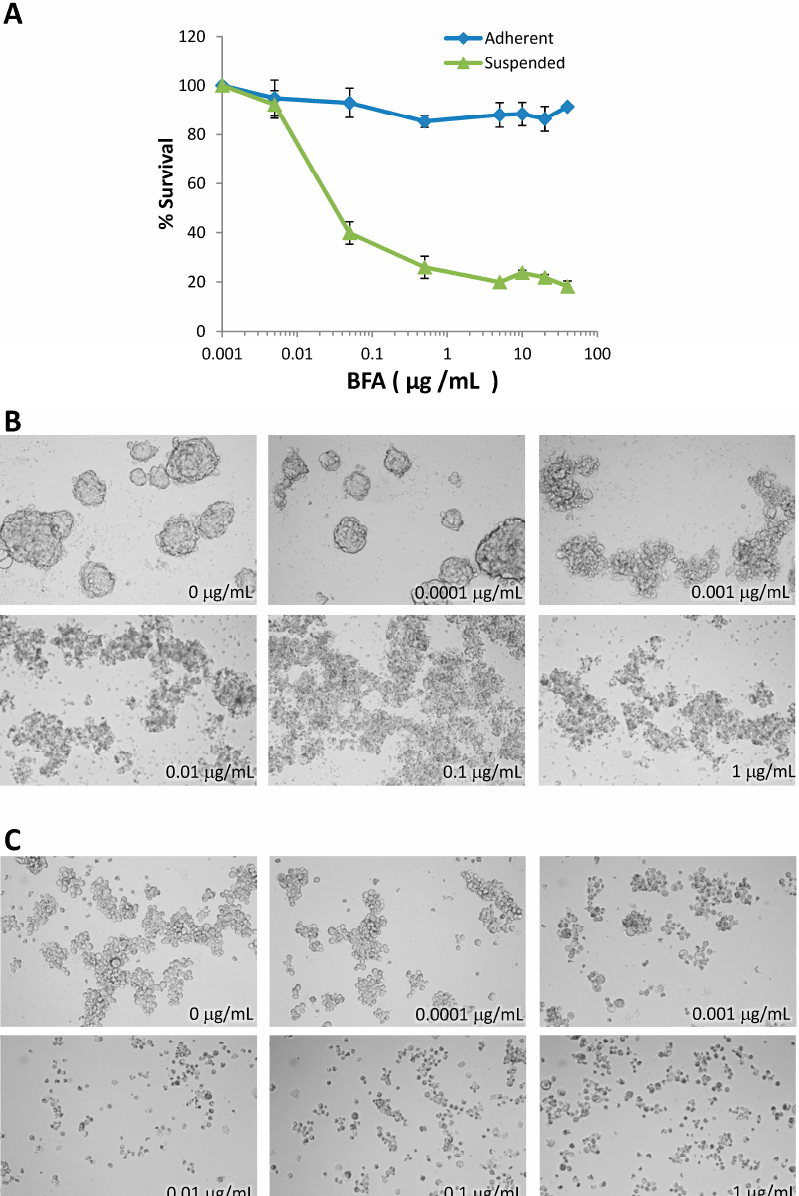
Figure 5. Inhibitory effects of BFA on MDA-MB-468, T47D, and MDA-MB-453 human breast cancer cell lines. ( A ) BFA displayed selective cytotoxicity toward suspended MDA-MB-468 cells. Tumorsphere cultures (7 d) of T47D ( B ) and MDA-MB-453 ( C ) treated with 0–1 μ g/mL BFA photographed under 10 X phase contrast